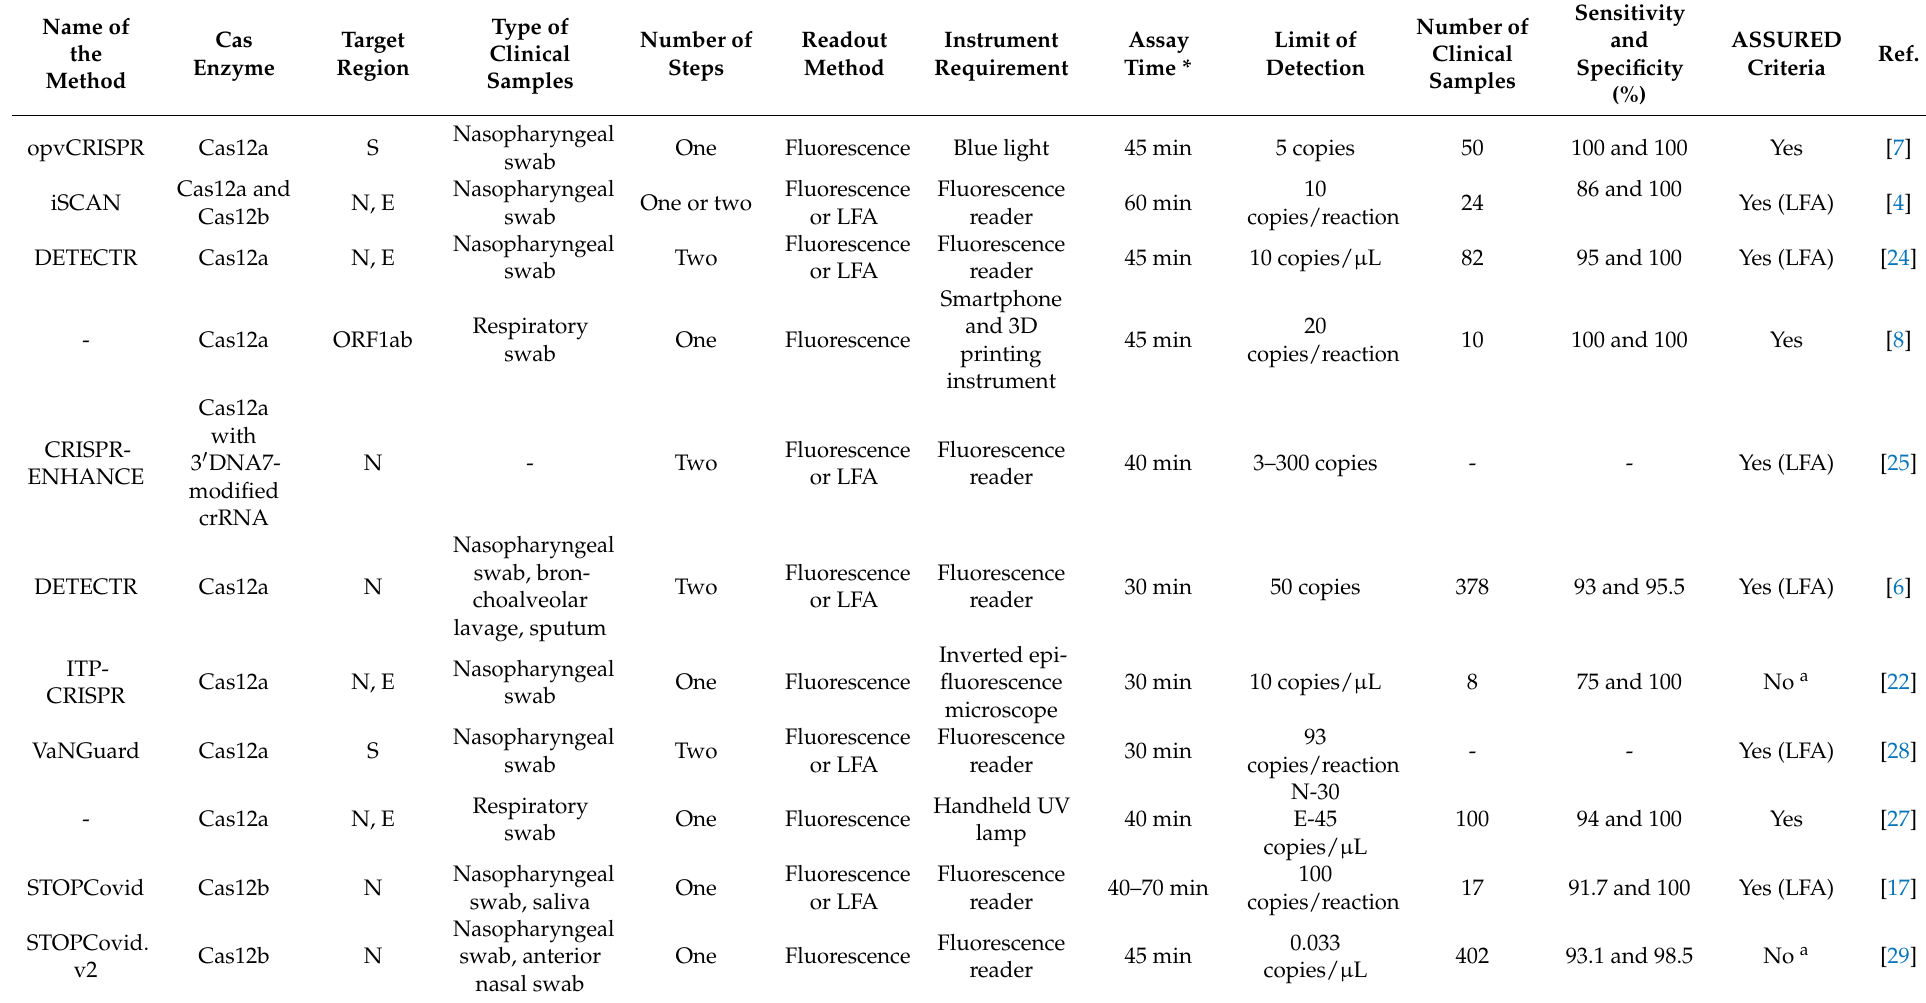
Table 1. Summary of Cas12- and Cas13-based detection of SARS-CoV-2 nucleic acid using RT-LAMP as an amplification